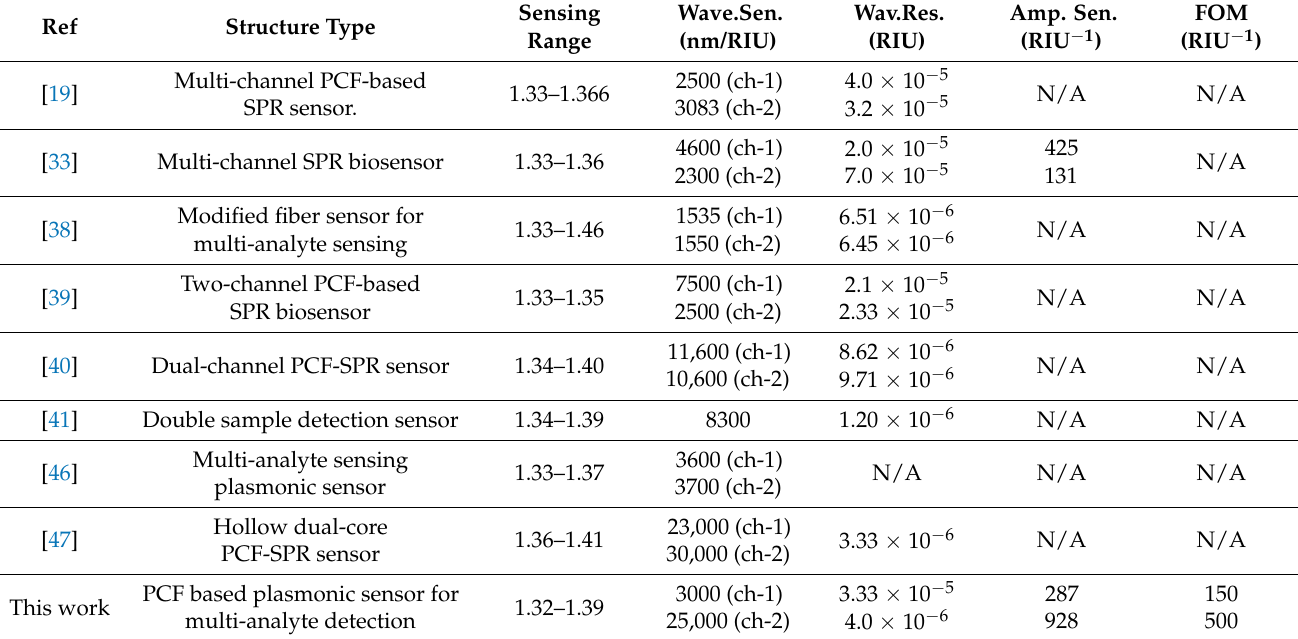
Table 2. Performance comparison of the proposed multi-channel PCF sensor with the reported